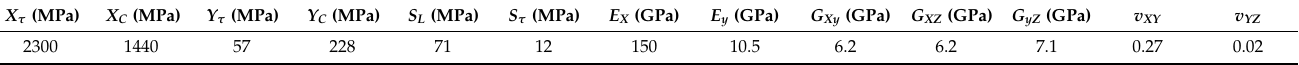
Table 2. Material properties of CFRP